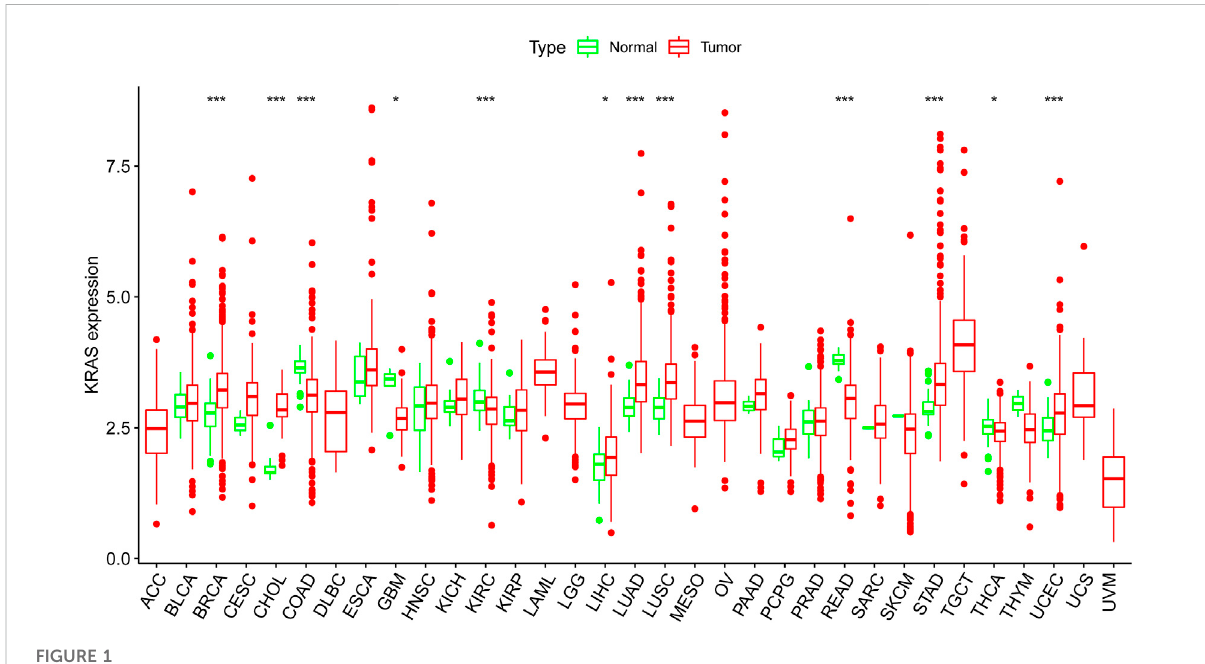
FIGURE 1 The KRAS expression level in cancer patients. Thirty-three kinds of tumor cancers. Expression of KRAS in tumors were performed by ggpubr (version 4.0.4) package of R (*** p < 0.001, ** p < 0.01, * p <